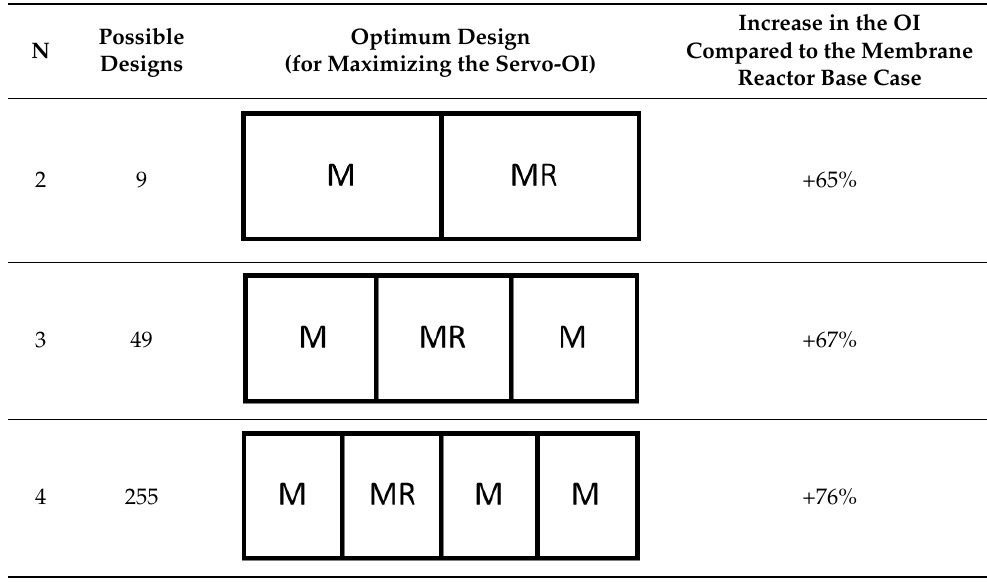
Table 3. Summary of the operability analyses for maximizing the AOS area.